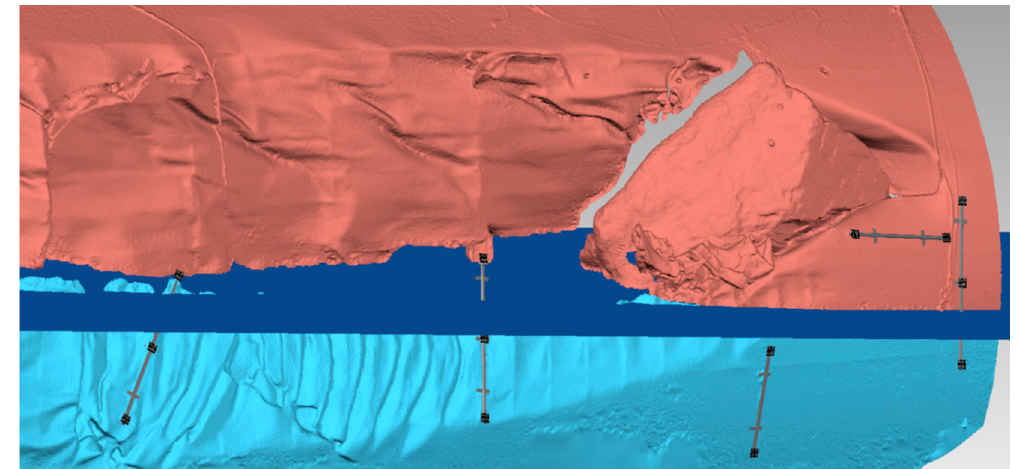
Figure 15. Merged mesh model with in blue the sea level.